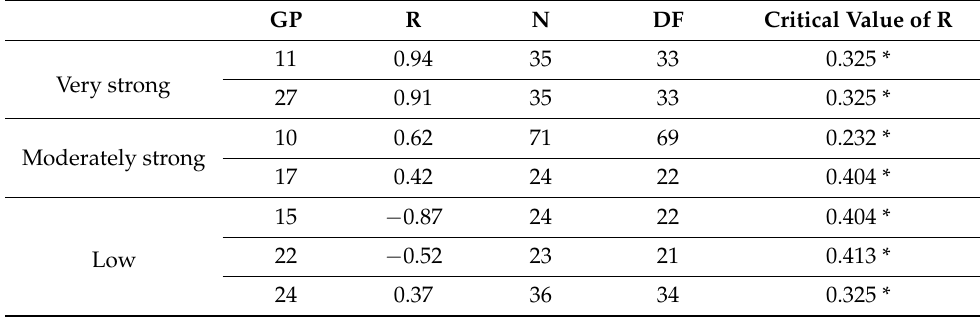
Table 7. Report of Pearson correlation values (R) for TC-PBZ-genomic profiles comparison. GPs are ranked into three groups: ones with a very strong correlation between the pair of genomic profiles (R ≥ 0.80); ones with a moderately strong correlation (0.40 ≤ R < 0.80); ones with a low correlation (R < 0.40). The statistical significance for each pair of correlations was calculated consulting the Table of Critical Values for Pearson’s R. N: total number of CNAs; DF: degree of freedom (N-2). Level of significance for a two-tailed test α = 0.05. * indicates statistically significant